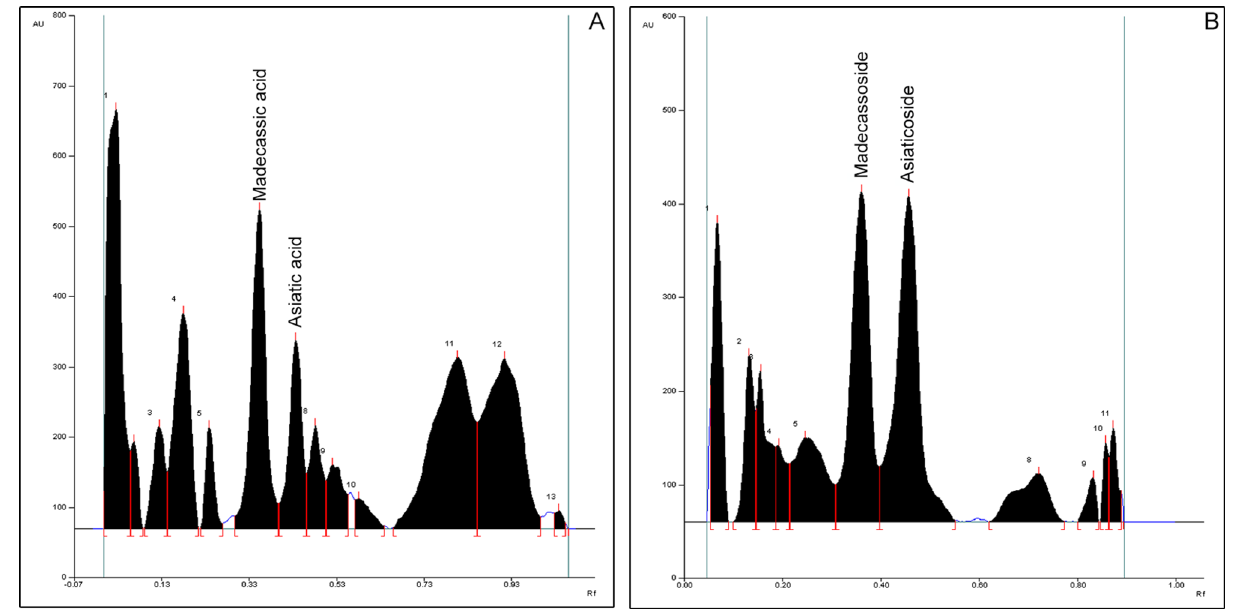
Figure 1. Representative HPTLC chromatograms of methanol extracts of C. asiatica accessions, ( A ) Ca-56 (ASA, MDA) and ( B ) Ca-52 (ASI, MAD); data scanning, documentation and analysis by CAMAG TLC Scanner 3, Reprostar 3 and WinCATS software 4.03